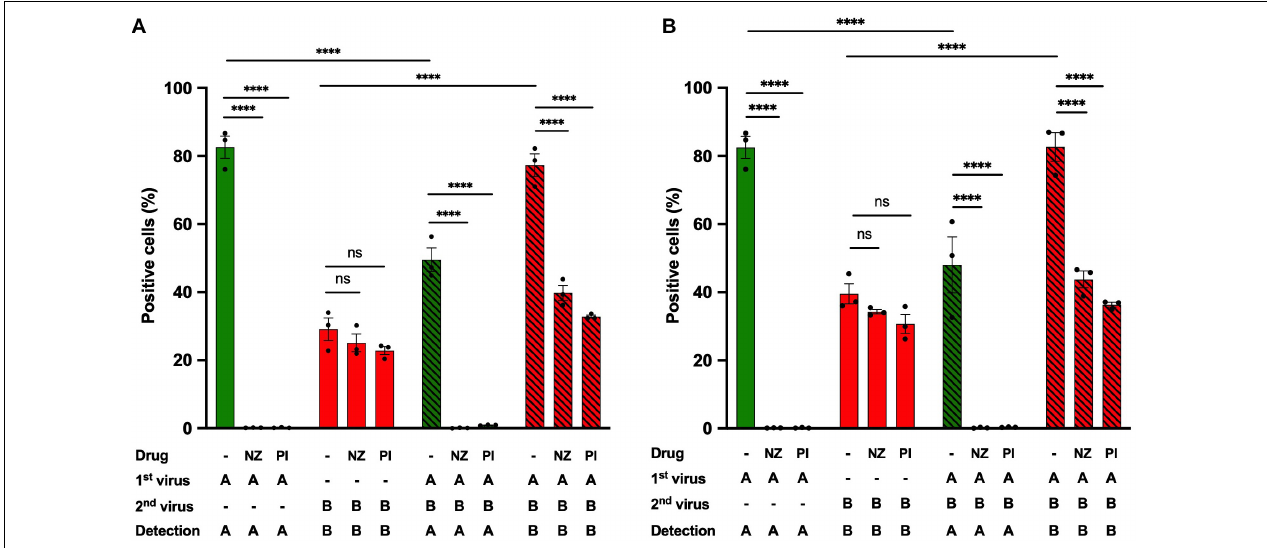
FIGURE 6 | Effect of IAV-specific antiviral compounds on heterotypic co-infections. A549 cells were infected with IAV-GFP for 1 h and then with an IBV-mCherry virus from two different stocks (A,B) in the presence or absence of the antiviral compounds nucleozin (1 µ M, NZ) or pimodivir (50 nM, PI). At 6 hpi, cells were analyzed by flow cytometry. The solid bars represent the proportion of fluorescent cells expressing GFP (in green) or mCherry (in red) upon control infection with IAV-GFP or IBV-mCherry alone. The hatched bars represent the proportion of fluorescent cells expressing GFP (in green) or mCherry (in red) upon co-infections. One experiment representative of three independent experiments performed in triplicate is shown (see Supplementary Figure S4 ). The mean ± S.D. of biological triplicates is shown. Three-way ANOVA test: multiple comparison, Tukey test, α = 0.05; ns, not significant; ∗∗∗∗ : adjusted p ≤